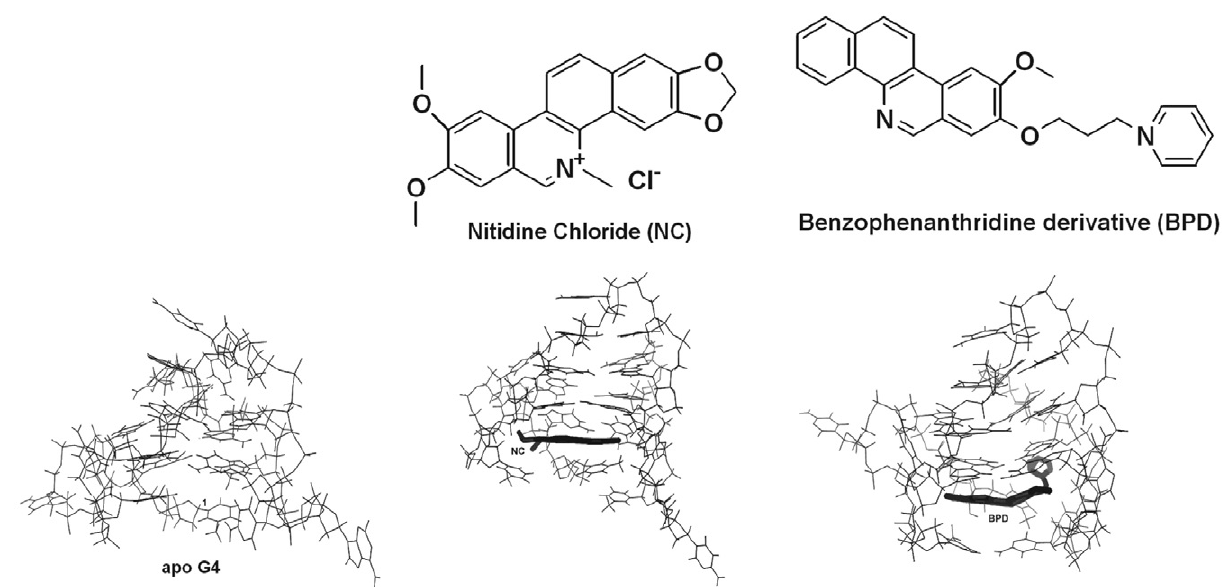
Figure 9. Among eight natural small molecules, NC and BPD were shown to have the most pronounced (and mutually comparable) affinity for G4 from the HIV-1 promoter. 105 NC is a thermodynamically unfavorable binder by increasing the conformational rigidity of apo G4, while BPD is a thermodynamically favorable binder by increasing the conformational flexibility of apo G4 in the asymptotic ( t →∞) regime of MD simulation. 66